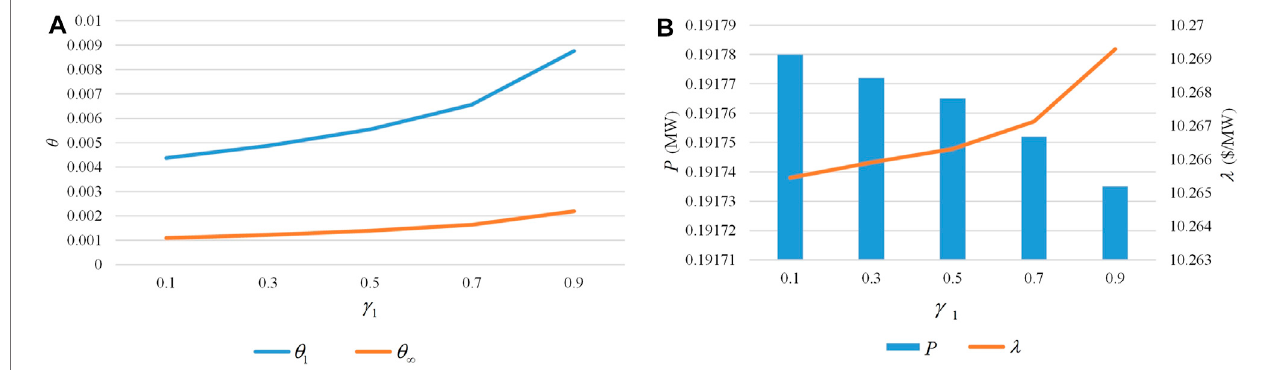
FIGURE 10 | (A) Impact of con fi dence on θ . (B) Impact of con fi dence on the fi nal transaction power and contract price.